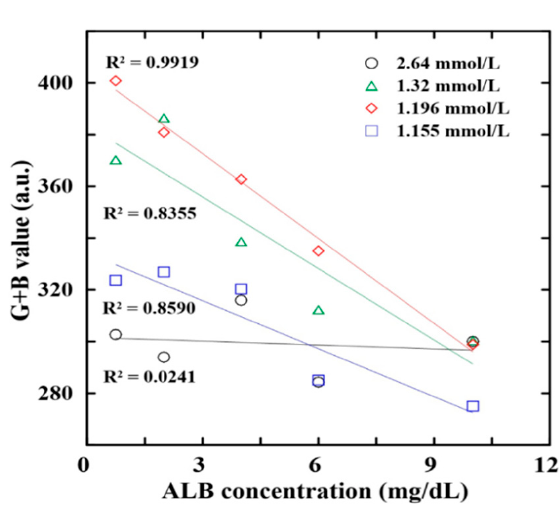
Figure 4. Effects of BCG concentration on G + B intensity value of reaction complexes with four different ALB contents.